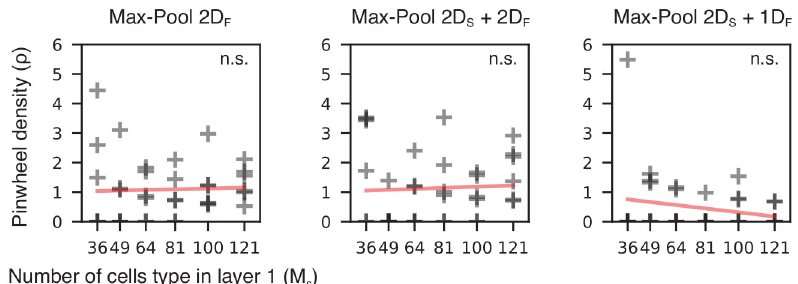
Fig 4. Pinwheel density does not depend on network size. Here we show that there is no relationship between the tested first layer’s network size ( M ) and the density of pinwheels ( ρ ). Pinwheel density is defined as the average s number of pinwheels per area unit (see section ‘Local homogeneity index (LHI)’). For all networks showing orientation maps, we found no significant trend between the size of the map, M s , and the pinwheel density, in line with neurophysiological